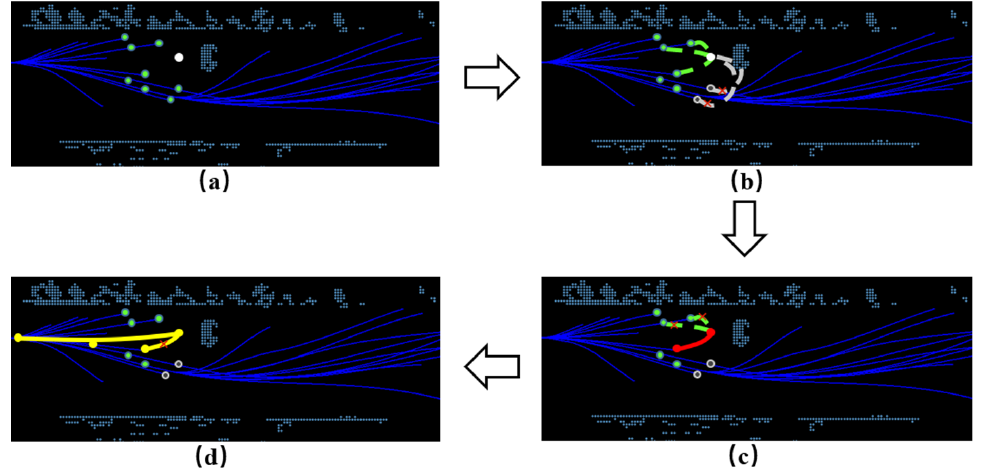
Figure 10. New rewire process of HDM-RRT, where ( a ) is the initial state, ( b ) is the collision and kinematic limitation, ( c ) shows the selection of the optimal parent node using the cost function and ( d ) shows the tracing of the parent node to the starting point to find out whether there is a better parent node.